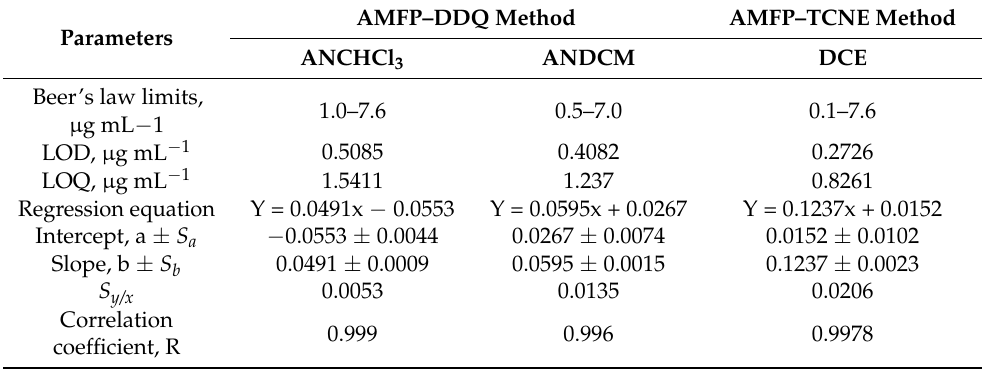
Table 5. Statistical data for the regression equation of AMFP determination methods.